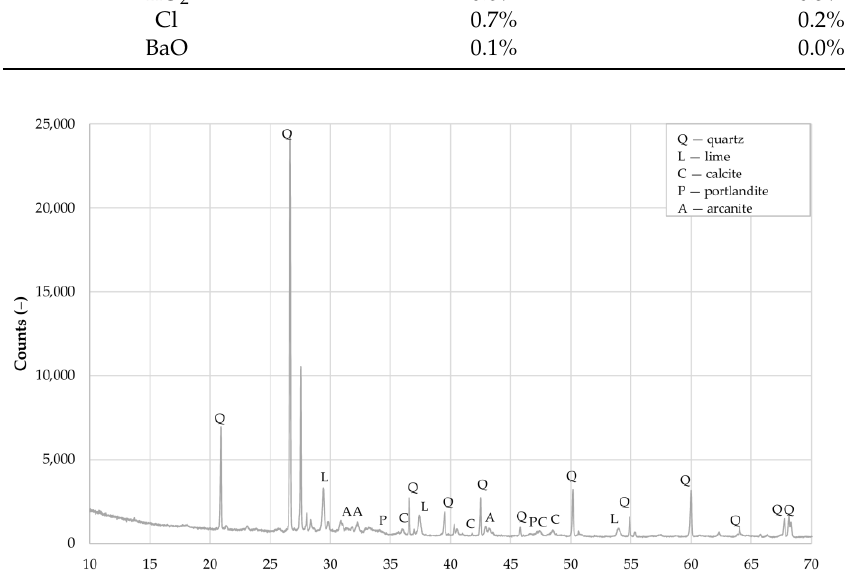
Figure 1. XRD analysis of biomass fly ash used in the study before activation.